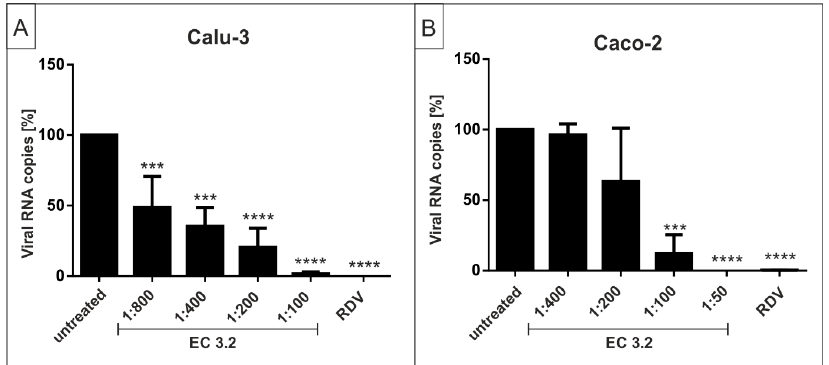
Figure 3. Liquid European black elderberry (EC 3.2) extract inhibits replication of SARS-CoV-2 Wuhan type in Calu-3 and Caco-2 cells. Calu-3 ( A ) and Caco-2 cells ( B ) were infected with the clinical isolate SARS-CoV-2 PR-1 at a MOI of 2 × 10 − 2 . One hour after infection and removal of input virus, cells were treated with indicated dilution steps of EC 3.2. A total of 1 μ M Remdesivir (RDV) was included as a positive control. Cell culture supernatants were harvested at 3 dpi. The virions were purified and analyzed by qRT-PCR. Bars show mean values of three independent experiments ± standard deviation. Statistical analysis was performed using a multiple comparison Kruskal–Wallis test (Anova) followed by Dunn’s post hoc test (*** p < 0.001; **** p < 0.0001 versus the